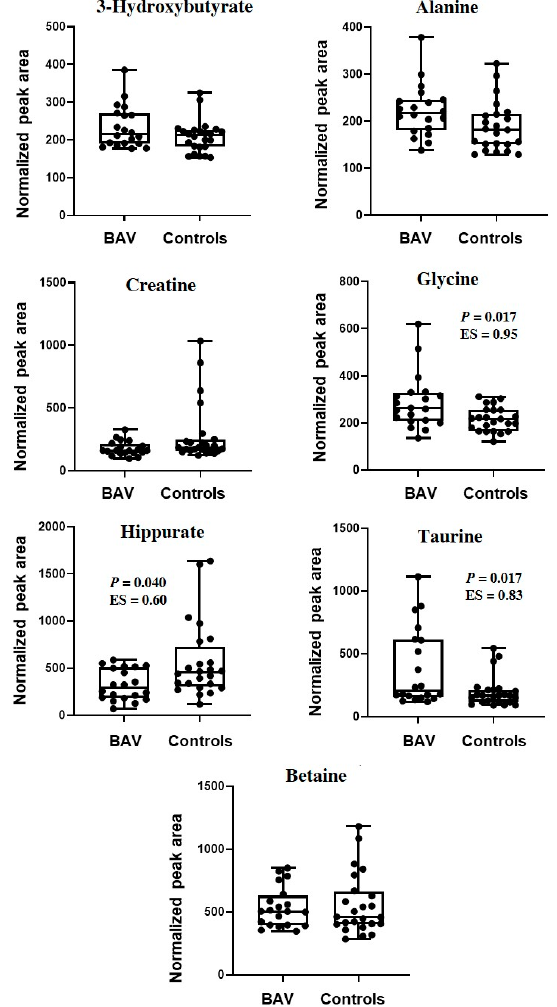
Figure 4. Box-and-whisker plots of the relative content of metabolites that were significantly per- turbed in BAV compared to controls as indicated by the OPLS-DA analysis of the NMR data set. Quantification was achieved after the calculation of the area under the corresponding peaks. The boxes show the median and the inter-quartile range for each metabolite in the two groups. Abbrevia- tion: ES, effect size value.